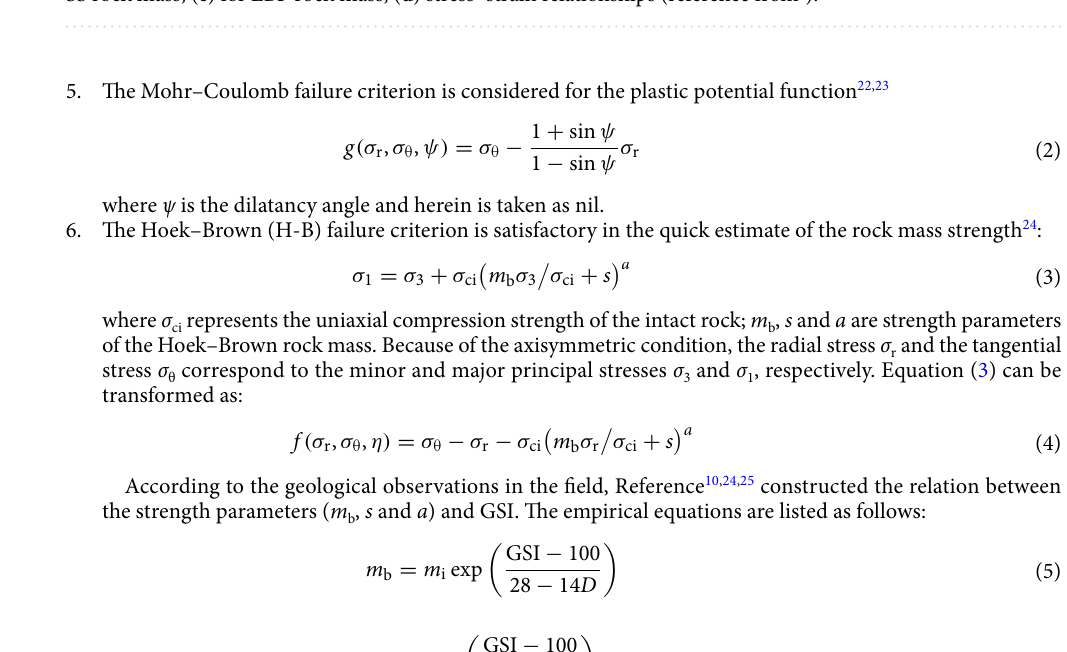
Figure 1. Schematic graph of excavation problem and stress–strain relationship: ( a ) for EPP rock mass; ( b ) for SS rock mass; ( c ) for EBP rock mass; ( d ) stress–strain relationships (reference from 3